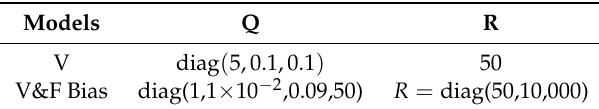
Table 7. Control Weights for the different sensors for data validation: V,terminal voltage; V&F Bias, fusion of both